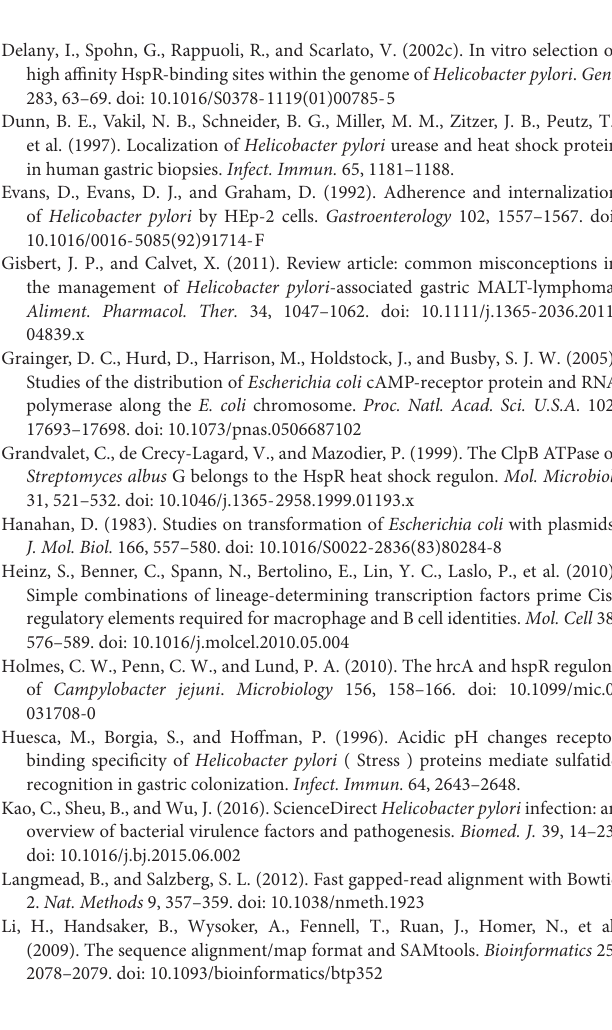
TABLE S2 | Library preparation and sequencing performances. TABLE S3 | Transcriptome of the wild type and (cid:49) hspR